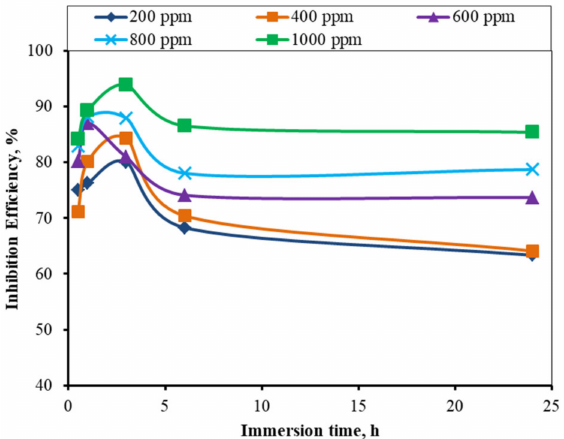
Figure 5. Variations in the inhibition efficiency of the different inhibitor solutions in the 1 M H 2 SO 4 solution versus time for the corrosion of mild steel (for various times).